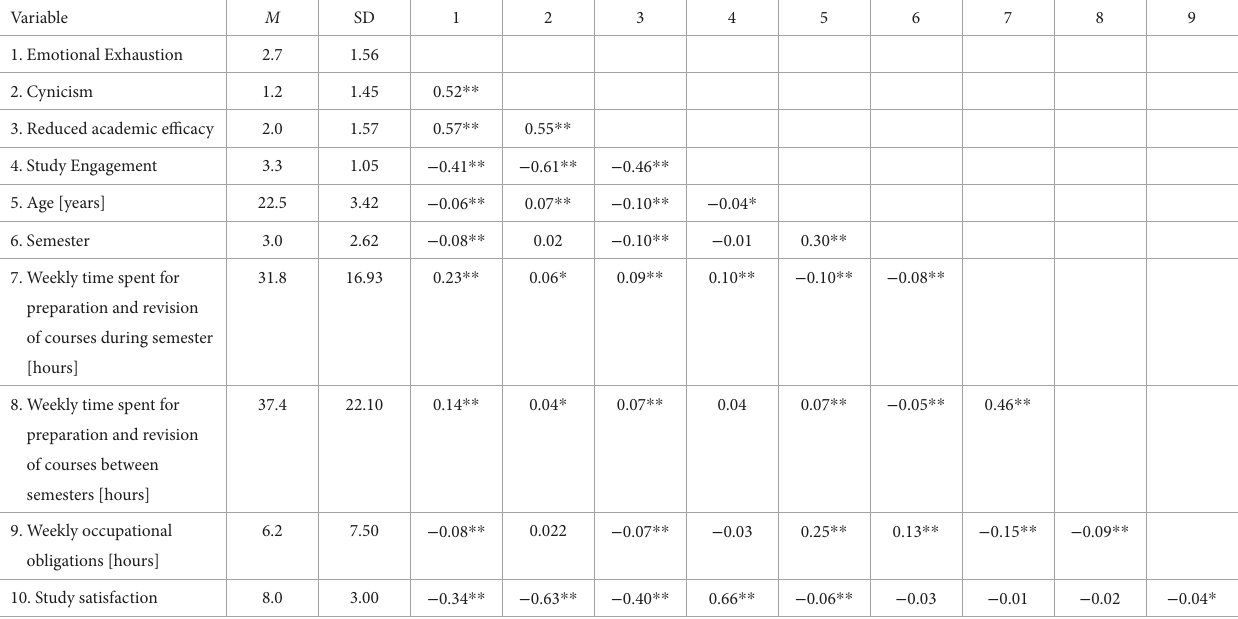
TABLE 2 Correlation table for included variables ( n =